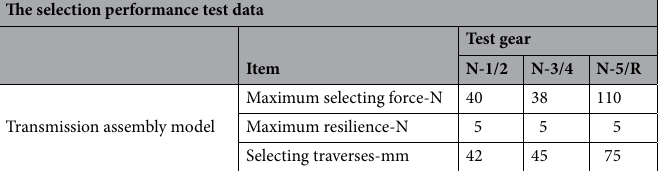
Table 2. Selecting performance comparison data of three